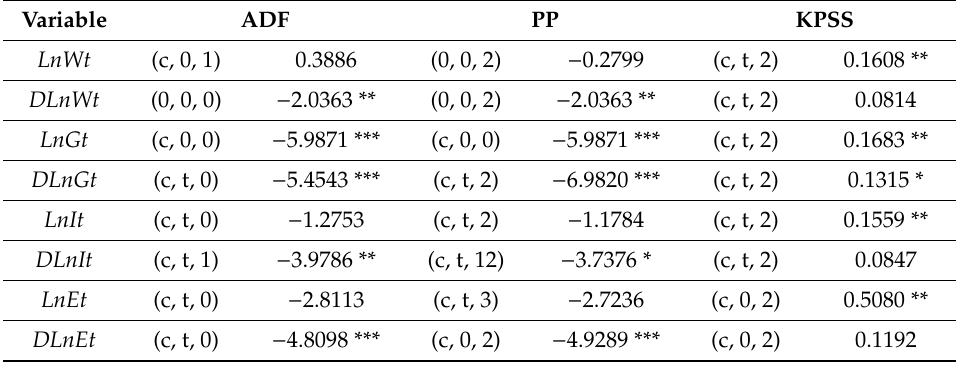
Table 3. Unit root test results.